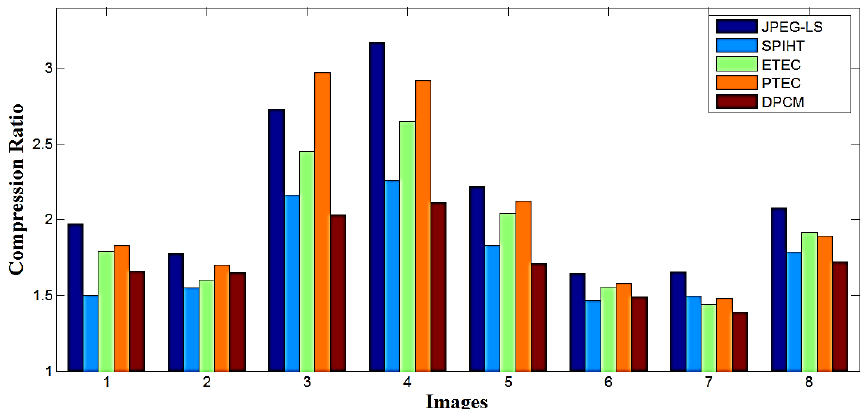
Figure 12. Comparison of compression ratio for non-pixelated images.